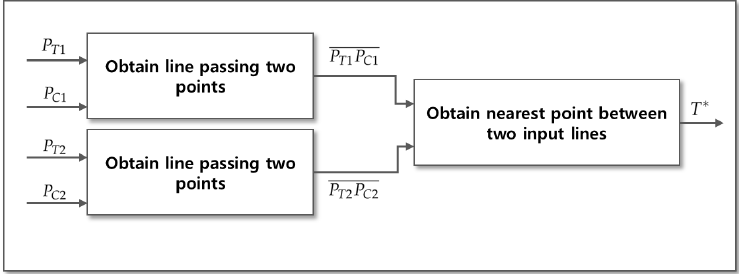
Figure 6. Process of translation